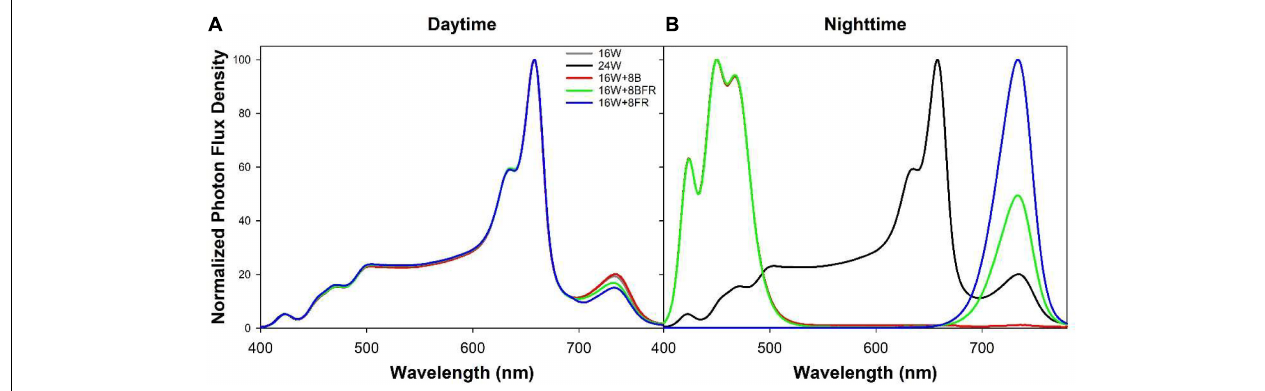
FIGURE 2 | Normalized photon flux density (PFD) of daytime (A) and nighttime (B) light treatments as determined with a Li-180 spectroradiometer during the night at the head of the